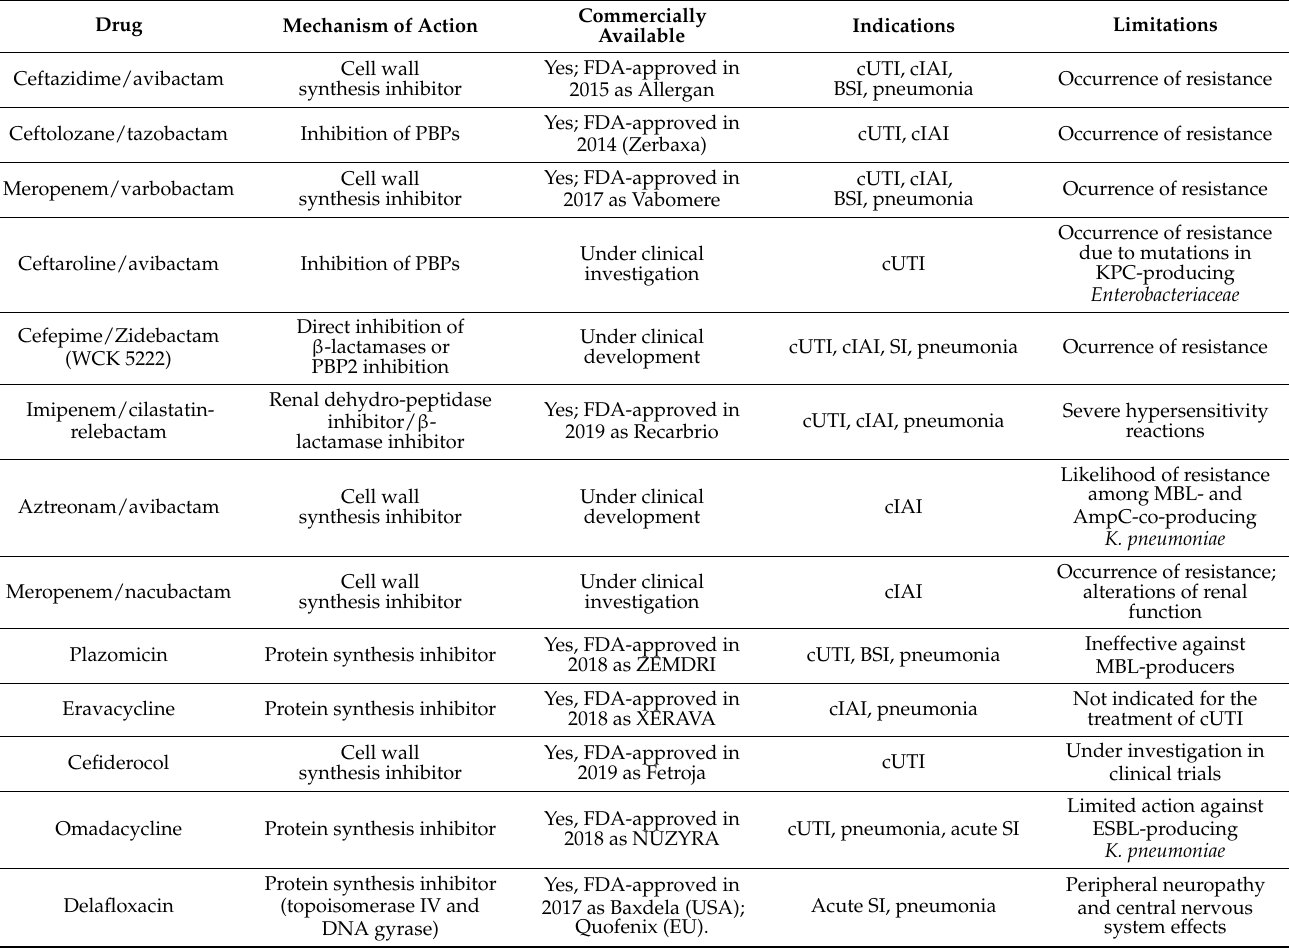
Table 1. Current promising antibiotics in treating carbapenem-resistant Enterobacterales (CRE) infections 1